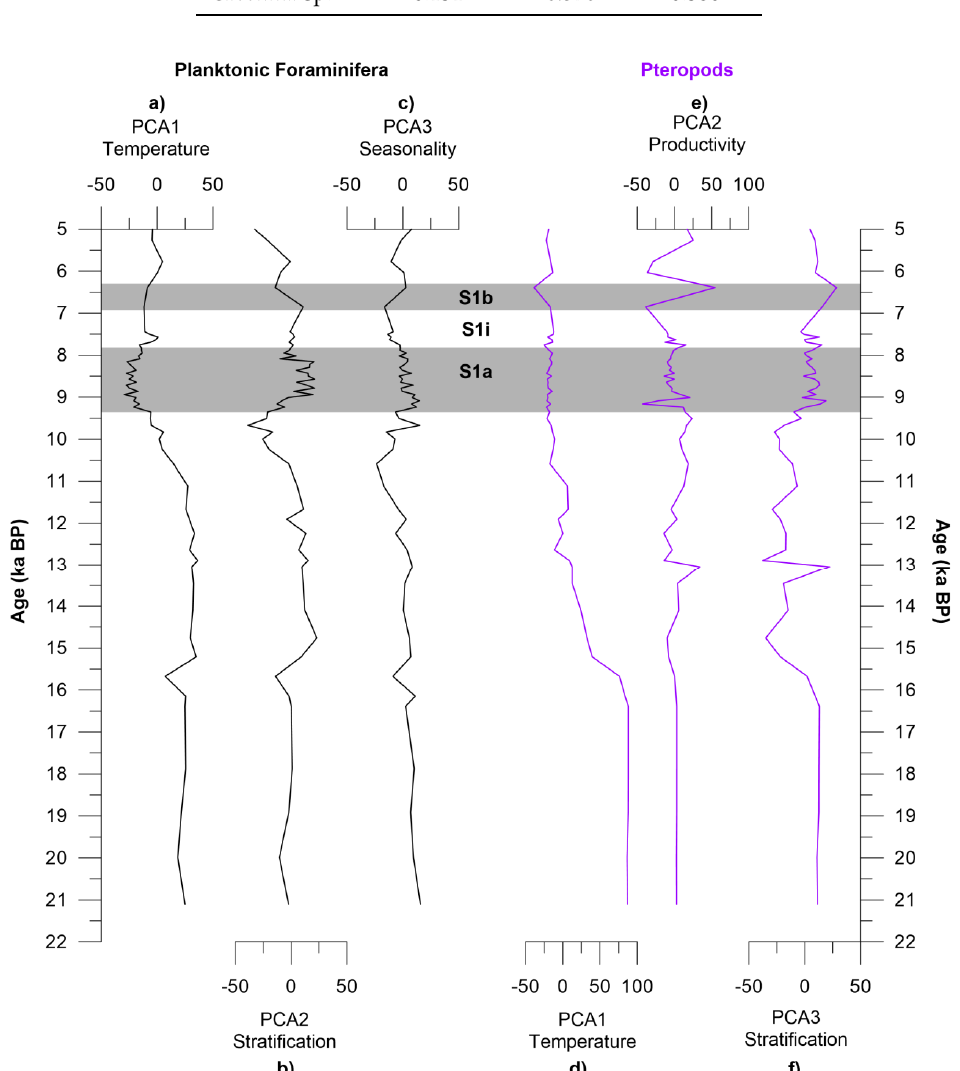
Figure 5. Environmental factors controlling planktonic foraminifera and pteropod distribution resulting from the PCA. ( a ) PCA1 of planktonic foraminifera as a temperature factor; ( b ) PCA2 of planktonic foraminifera as a stratification factor; ( c ) PCA3 of planktonic foraminifera as a seasonality factor; ( d ) PCA1 of pteropods as a temperature factor; ( e ) PCA2 of pteropods as a productivity factor; and ( f ) PCA3 of pteropods as a stratification factor.